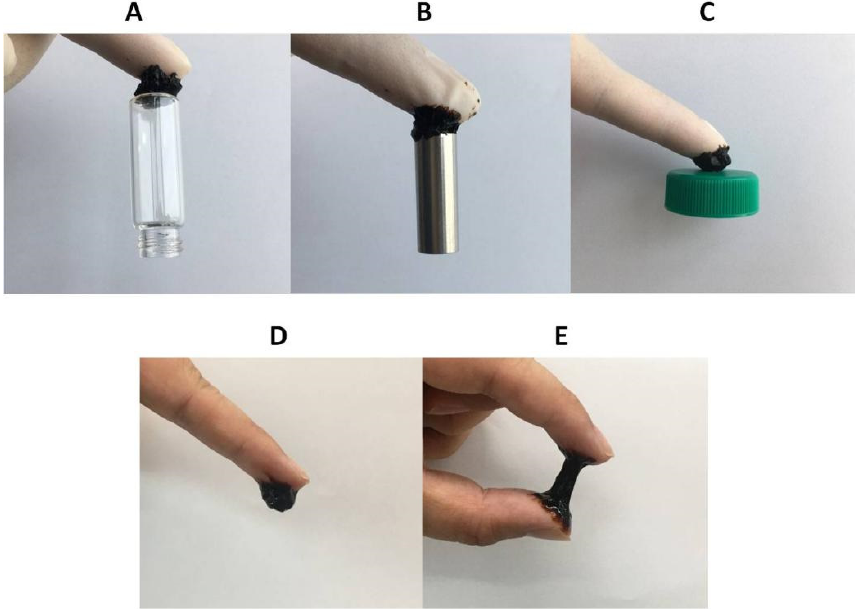
Figure 5. Adhesion of DA-GLT/AgNPs composite hydrogels to ( A ) glass, ( B ) metal, ( C ) plastic, and ( D , E ) skin.